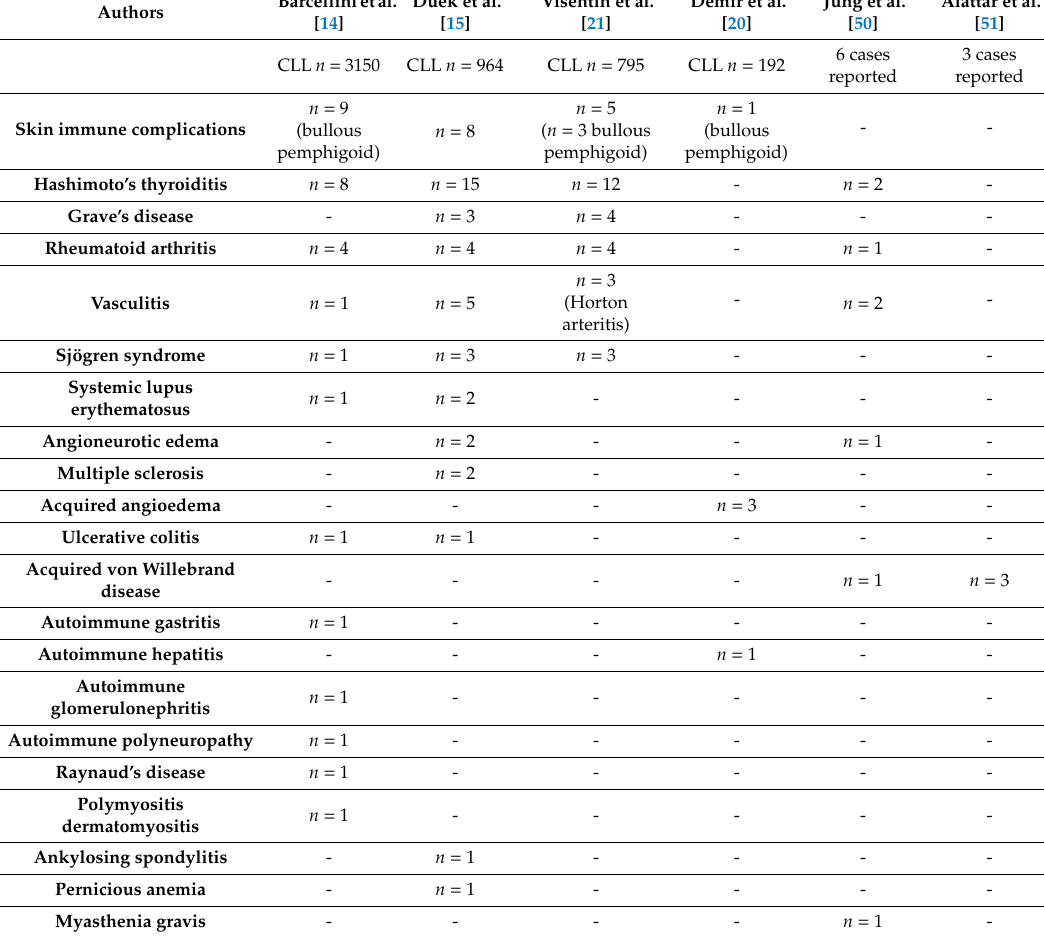
Table 2. Reported cases of non-hematological autoimmune phenomena in